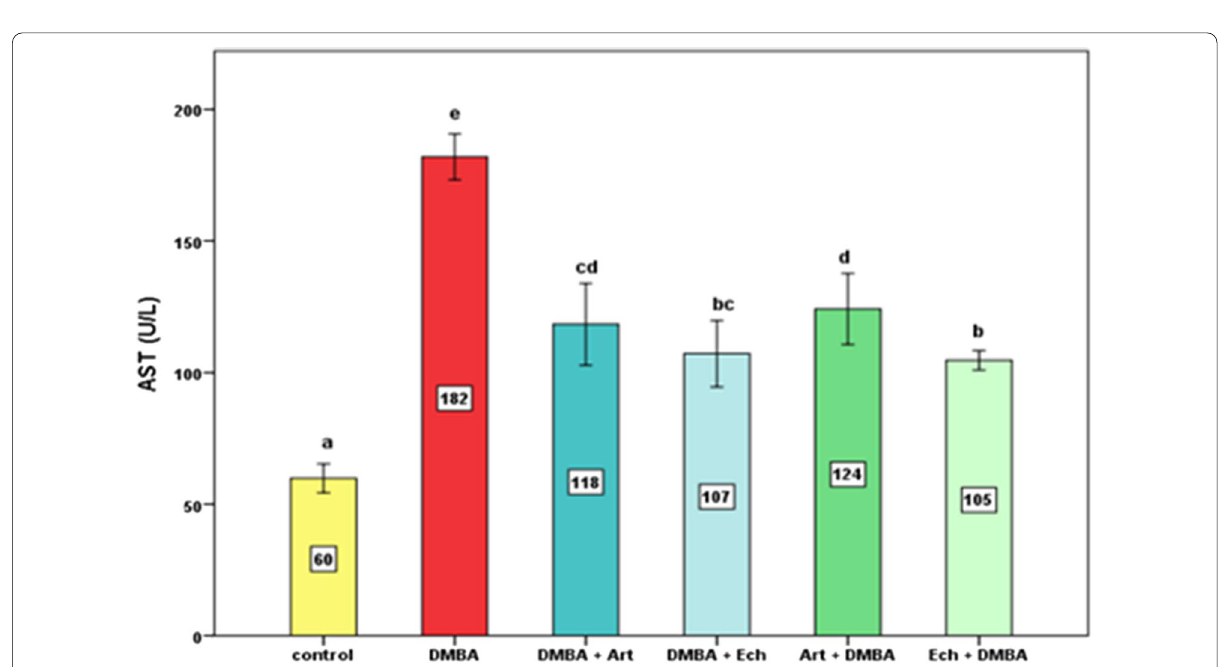
Fig. 2 Effect of treatment or protection with Artemisia or Echinacea on serum aspartate aminotransferase (AST) activity (U ∕ L) in DMBA‑administered rats of all experimental groups. Values with different letters above columns are considered significantly different ( P ˂ 0.05). Values with same letters above columns are considered non‑significantly different ( P ˂